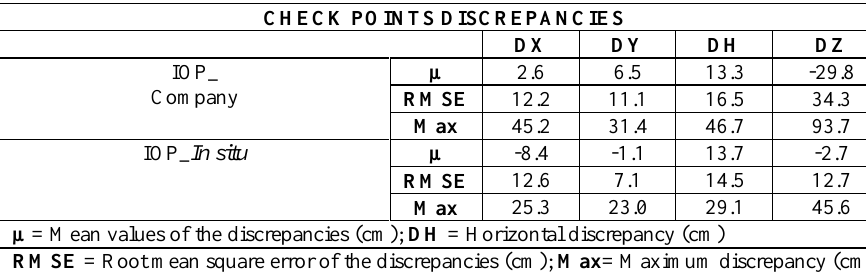
Table 4. Shows the results of discrepancies analysis performed in check points from the ISO experiment of the first block without control points.